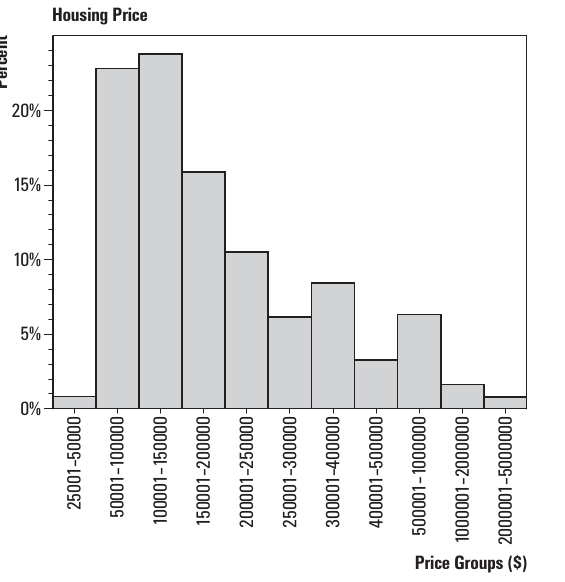
Figure 1. Sale prices for houses